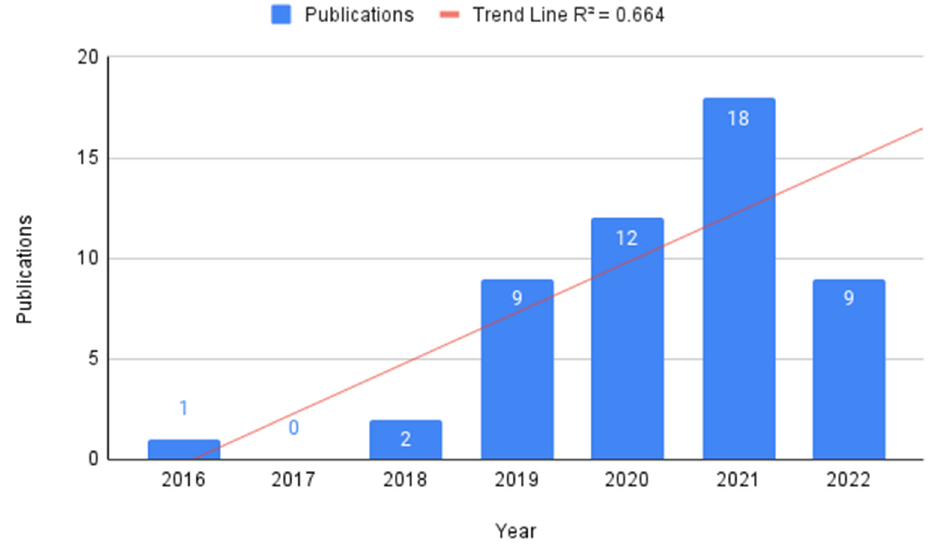
Figure 3. Distribution of publications from September 2016 to June 2022.